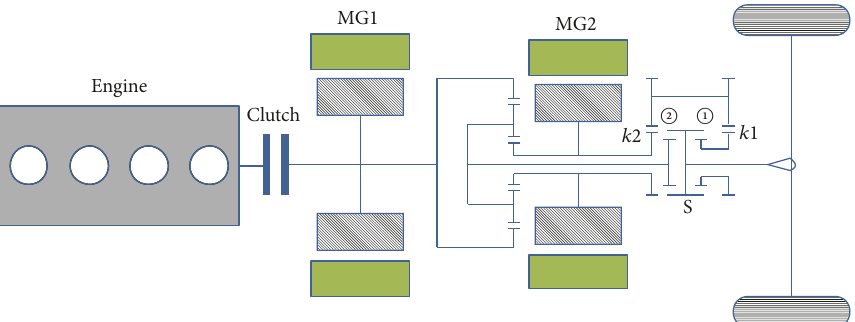
Figure 1: Simplified structural diagram of new HEV system (S: shift synchronizer, MG1: generator, MG2: motor, and 𝐾1/𝐾2 : gear